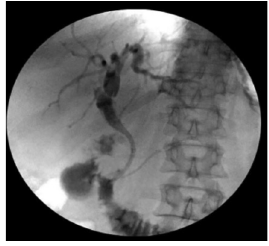
Figure 4. Stent placement and Cholangiography.